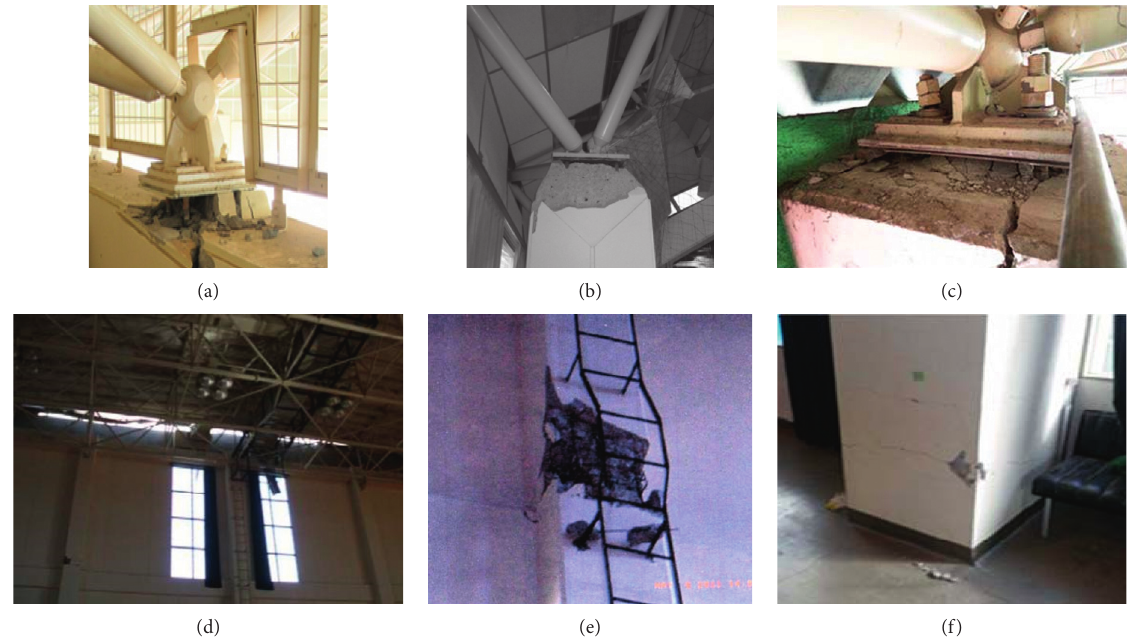
Figure 2: Damage of bearings and RC columns of spatial structures in Tohoku earthquake. (a) Bearing-1, (b) bearing-2, (c) bearing-3, (d) column middle-1, (e) column bottom-2, and (f) column